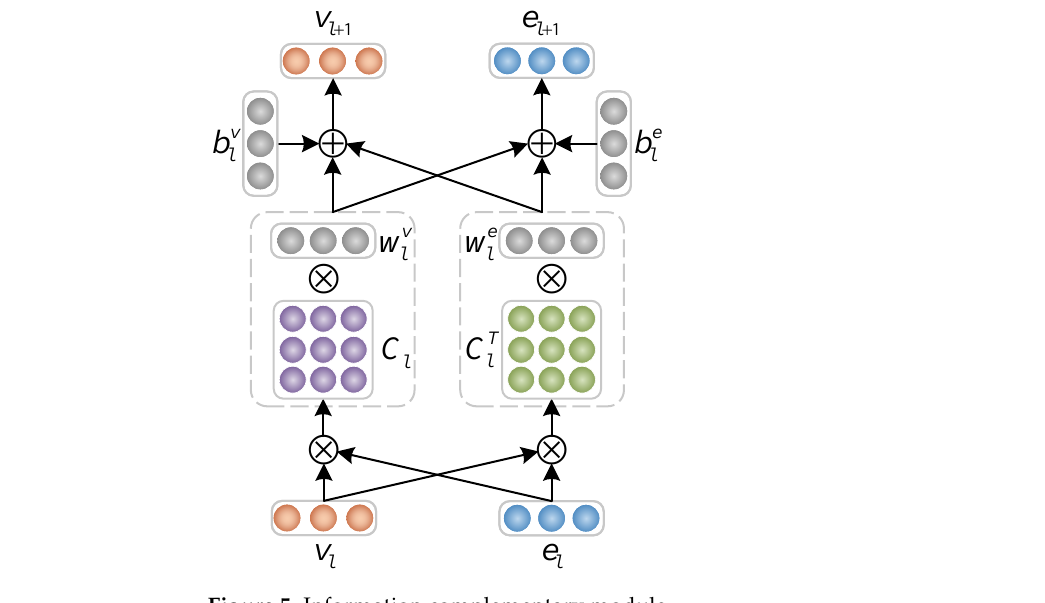
Figure 5. Information complementary